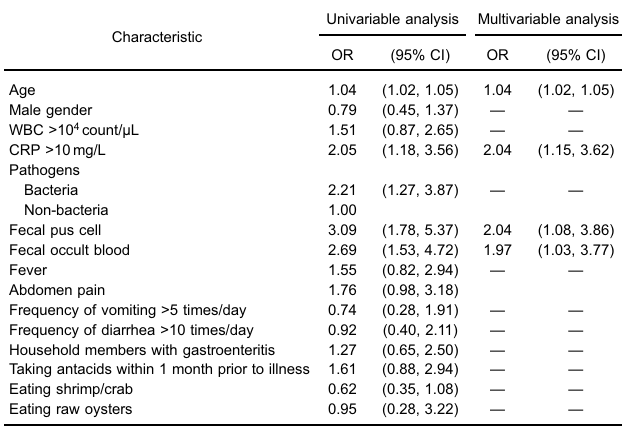
Table 3. Risk factors for gastroenteritis in the matched case- control study (612 paired participants)